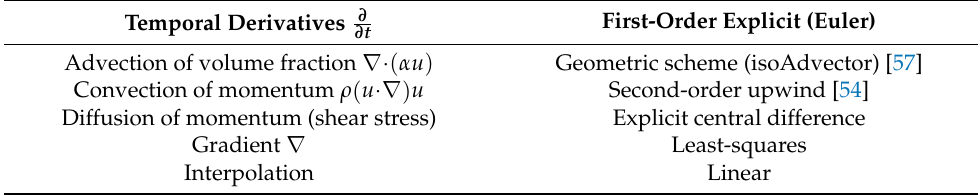
Table 3. Summary of discretization schemes used in the presented simulations.